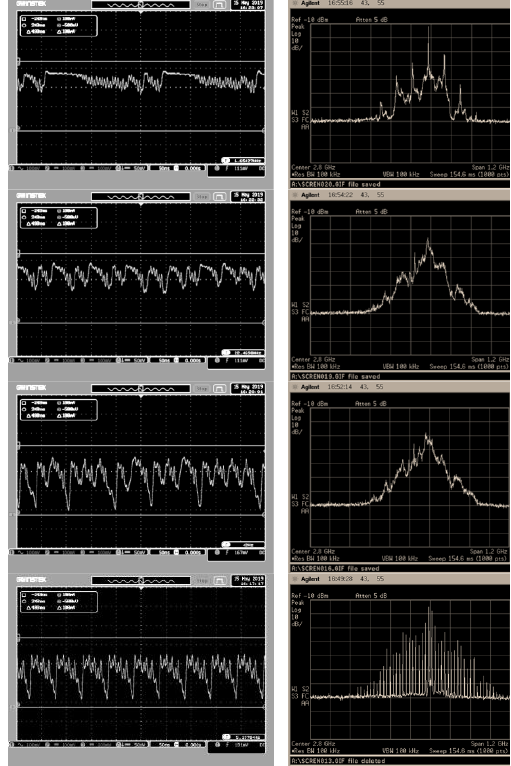
Fig. 6. Envelopes and spectra of output signal while reducing losses of coupling channel at small oscillators frequencies detuning 2-3 MHz.